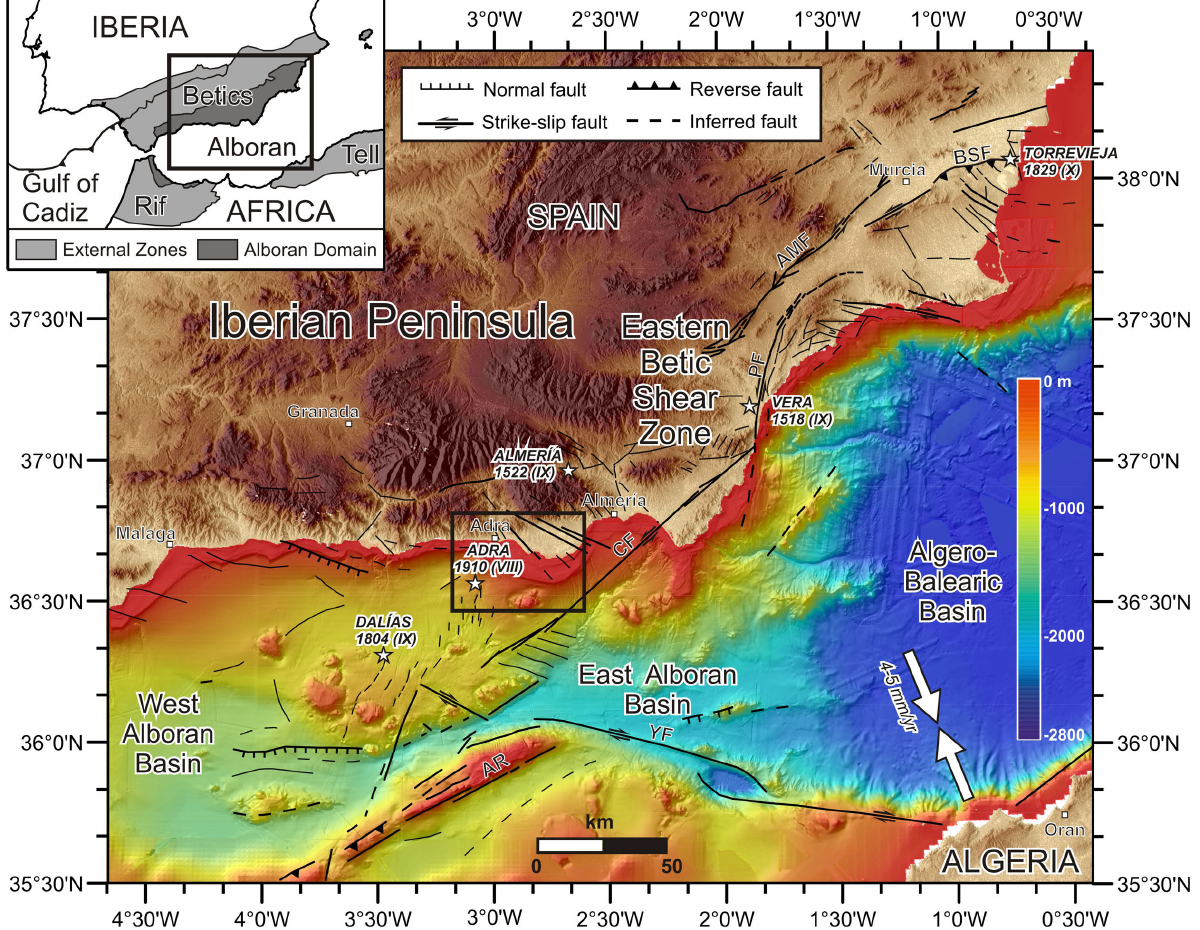
Fig. 1. Regional topographic and bathymetric map of the southeast Iberian margin constructed from digital grids released by SRTM-3, IEO bathymetry (Ballesteros et al., 2008; Mu˜noz et al., 2008) and MEDIMAP multibeam compilation (MediMap et al., 2008) at ∼ 90m grid-size. Epicenters of the largest historical earthquakes (MSK Intensity > VIII) in the region are depicted by a white star (I.G.N., 2010). Grey arrows pointing opposite each other show the direction of convergence between the Eurasian and African plates from NUVEL1 model (DeMets et al., 2010). The black outlined rectangle depicts the study area presented in Fig. 2. BSF: Bajo Segura Fault; AMF: Alhama de Murcia Fault, PF: Palomares Fault, CF: Carboneras Fault, YF: Yusuf Fault, AR: Alboran Ridge. Inset: Plate tectonic setting and main geodynamic domains of the south Iberian margin along the boundary between the Eurasian and African